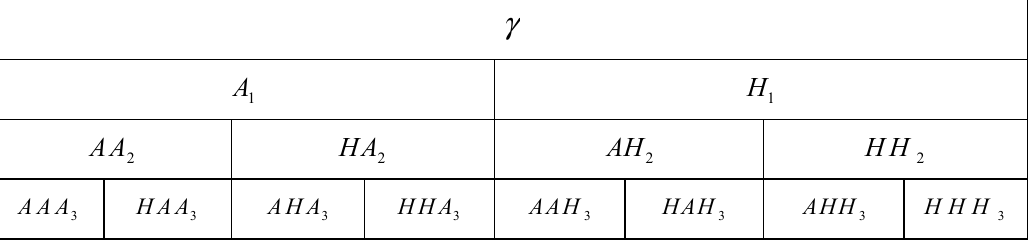
Figure 2. Wavelet packet decomposition tree.